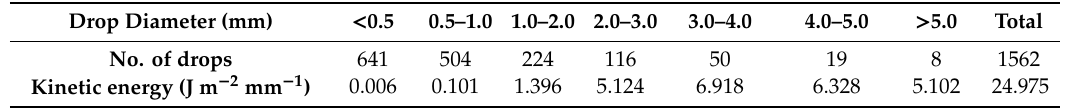
Table A1. Measured drop spectrum of the SP-02 rainfall simulator in the field at a pressure of 0.41 KPa using WATOR (Macherey-Nagel) adsorption papers and digital image